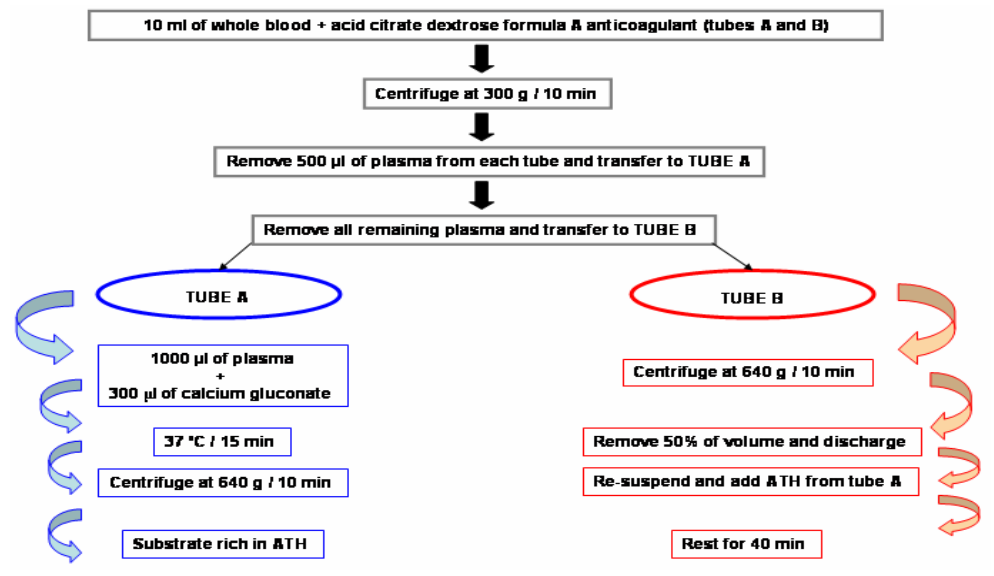
FIGURE 1 - Diagram of the preparation of the autologous thrombin (ATH) and platelets-rich plasma (PRP)